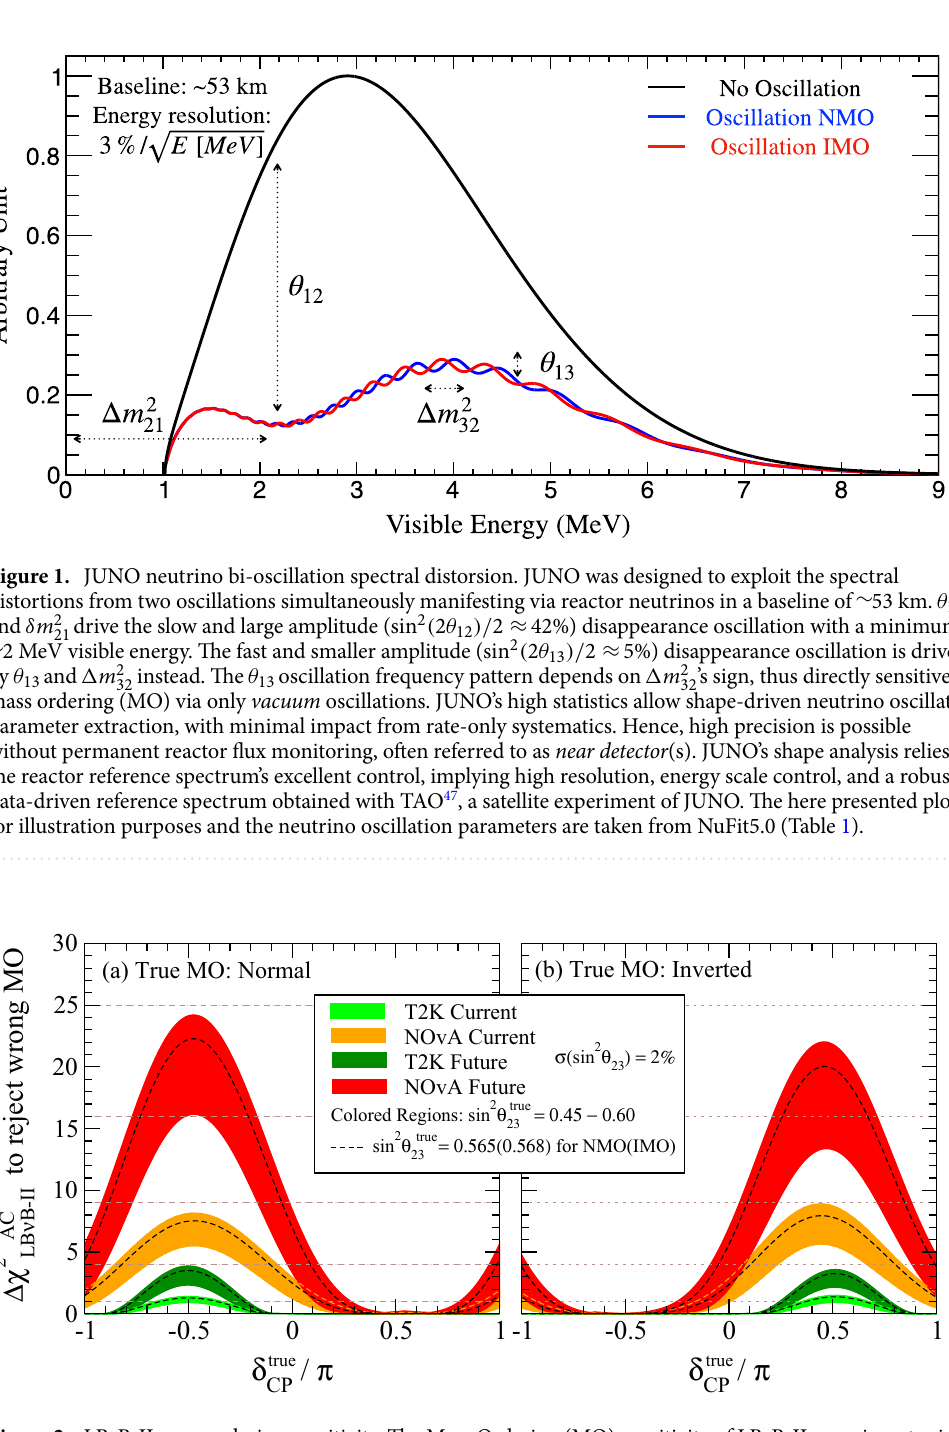
Figure 2. LB ν B-II mass ordering sensitivity. The Mass Ordering (MO) sensitivity of LB ν B-II experiments via the appearance channel (AC), constrained to a range of θ 23 , is shown as a function of the “true” value of δ CP . The bands represent the cases where the “true” value of sin 2 θ 23 lies within the interval [0.45, 0.60] with a relative experimental uncertainty of 2%. The sin 2 θ 23 = 0.60 (0.45) gives the maximum (minimum) sensitivity for a given value of δ CP . The black dashed curves indicate the NuFit5.0 best fitted sin 2 θ 23 value. The NMO and IMO sensitivities are illustrated respectively in the ( a ) and ( b ) panels. The sensitivity arises from the fake CPV effect due to matter effects, proportional to the baseline ( L ). The strong dependence on δ CP is due to the unavoidable degeneracy between NMO and IMO, thus causing the sensitivity to swig by 100%. T2K, now (light green) and future (dark green), exhibits minimal intrinsic sensitivity due to its shorter baseline ( L T2K = 295 km). Instead, NOvA, now (orange) and future (red), hold leading order MO information due to its larger baseline ( L NOvA = 810 km). The future full exposure for T2K and NOvA implies ∼ 3 times more statistics relative to AC today. These curves are referred to as �χ 2 LB ν B and were derived from data as detailed in Appendix